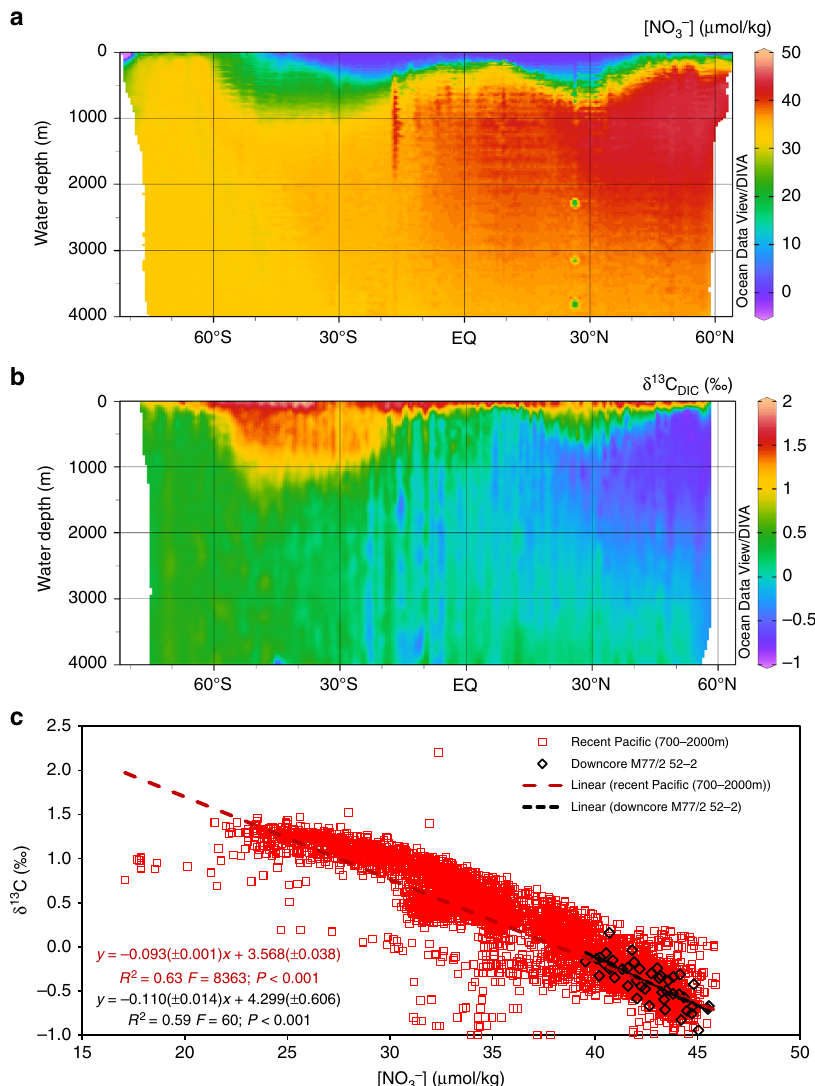
Fig. 2 Distribution of NO 3 - and δ 13 C DIC in the modern Paci fi c and [NO 3 − ]- δ 13 C DIC -coupling in the intermediate Paci fi c - modern and downcore. All data for the modern Paci fi c have been taken from the GLODAPv2 database 34 . a Distribution of [NO 3 − ] in the modern Paci fi c 34 . b Distribution of δ 13 C of dissolved inorganic carbon (DIC; δ 13 C DIC ) in the modern Paci fi c 34 . The Ocean Data View software has been used to compile these plots 62 . c Correlation between [NO 3 − ] and δ 13 C DIC in intermediate water depths (700 – 2000 m) of the modern Paci fi c (red, N = 4779) and between [NO 3 − ] BW and δ 13 C FORAM in the sediment record of M77/2 52-2 (black, N = 44). Both linear regressions neither differ signi fi cantly in slope ( P = 0.15) nor in intercept ( P = 0.13). Due to graphical reasons all δ 13 C below − 1 ‰ have been cut in this plot, although they were included into the fi t. For a complete plot of all data points